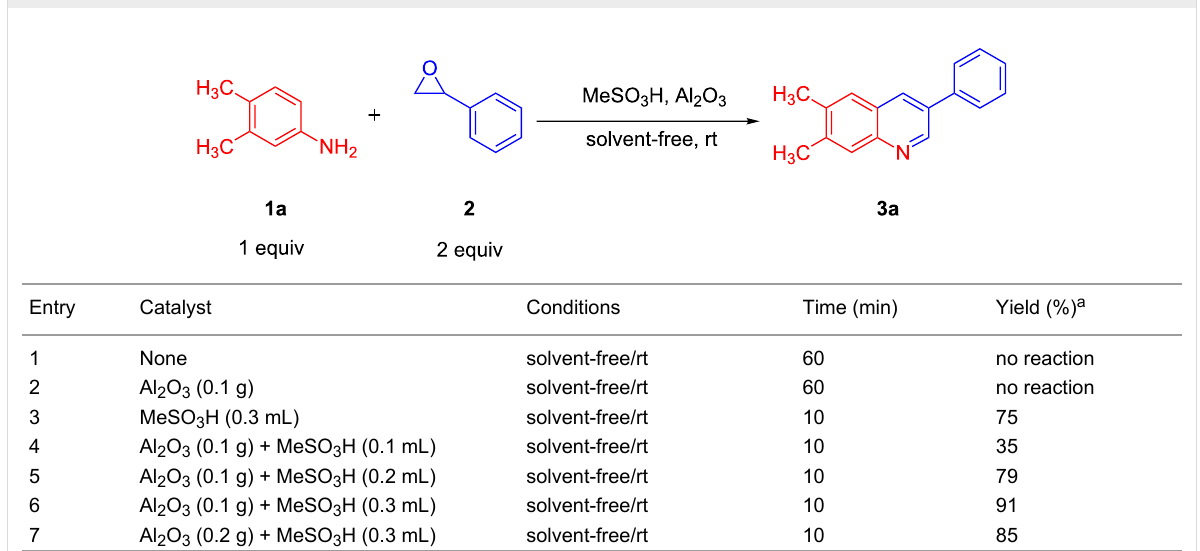
Table 1: Optimization studies for the synthesis of 6,7-dimethyl-3-phenylquinoline ( 3a ) from 3,4-dimethylaniline ( 1a , 1.0 mmol) with styrene oxide ( 2 , 2.0 mmol) in open